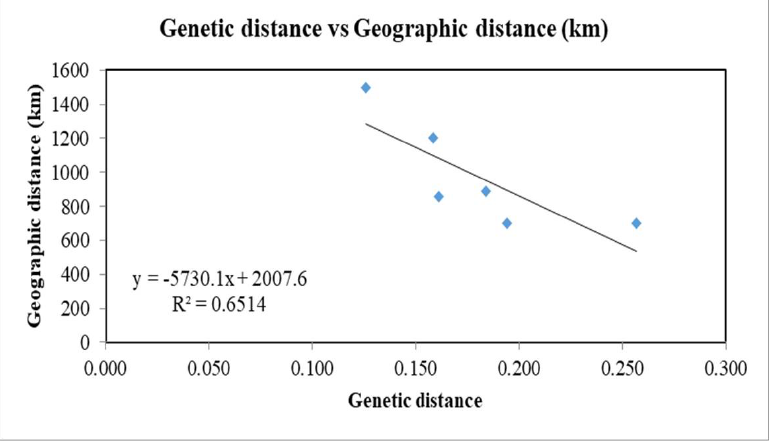
Figure 6. Mantel test showing the correlation between genetic distance and geographic distance of groups for the recovered populations of Meloidogyne javanica from Iran.